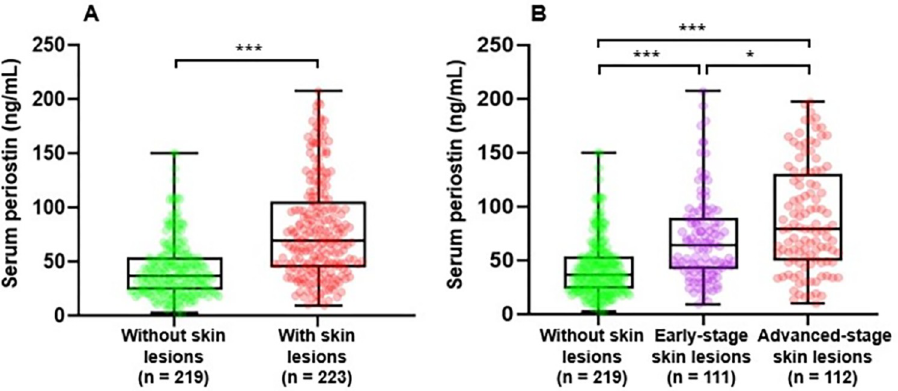
Fig 3. Comparison of the distribution patterns of serum periostin in the different stages of skin lesions using box and whisker plots. (A) Comparison between the groups of participants with and without skin lesions (B) Comparison among the participants without, early- and advanced-stage skin lesions groups. The center line indicates the median value, the box contains the 25th to 75th percentiles of the dataset. The whiskers mark the minimum and maximum values. The dots show the individual data points. Mean rank differences were assessed by using the Mann- Whitney U test (A), and the Kruskal-Wallis test followed by Dunn-Bonferroni post hoc test (B) between each skin lesions group. ��� p < 0.001; � p <